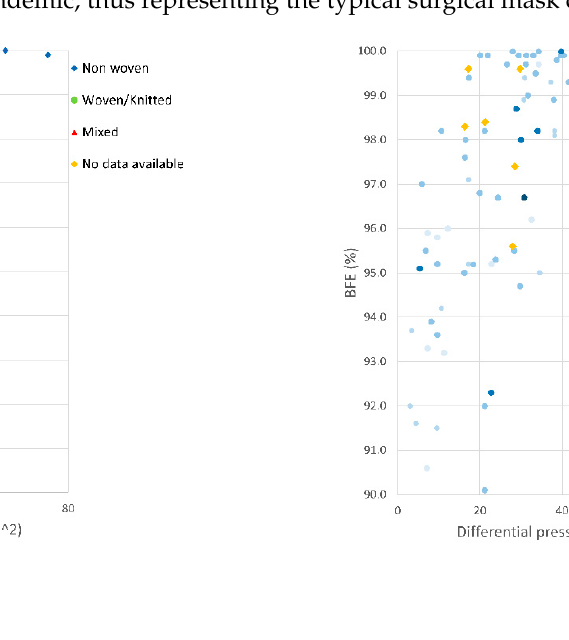
Figure 10. Mask performance grouped by fiber structure of the layers ( a ) and by number of layers ( b